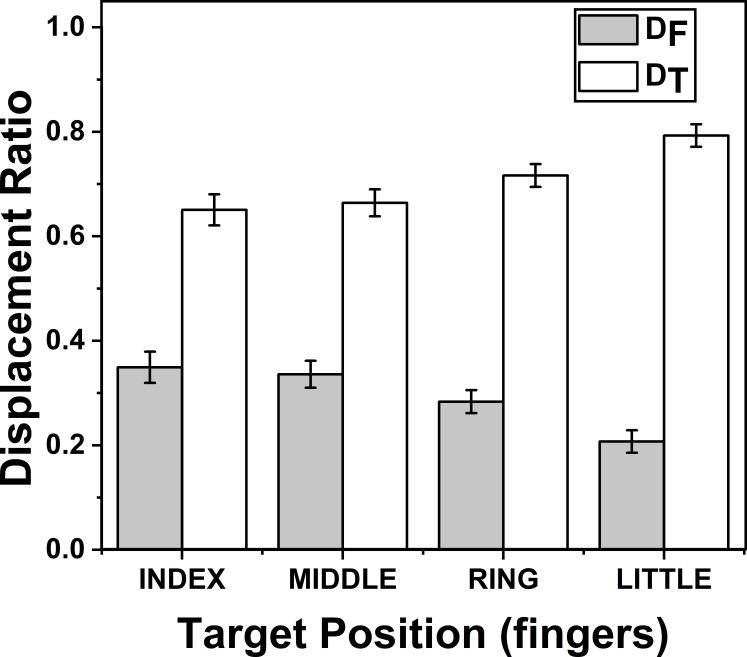
Change of Displacement Ratio for different target finger positions.DF reduces significantly (p < 0.01) when the target finger was changed from index to little finger while DT increases significantly (p < 0.01) when the target finger was changed in the same order. A higher value of D indicates a greater contribution. The columns and bars indicate means and standard error of means.